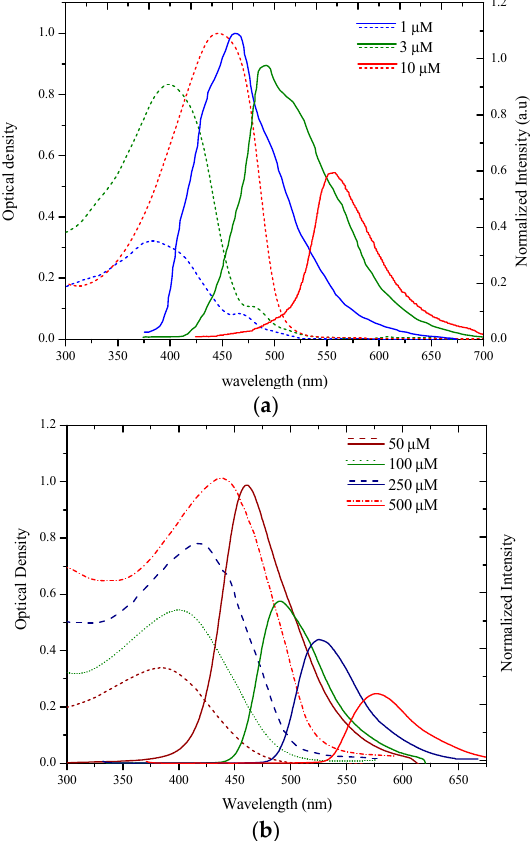
Figure 3. ( a ) The absorption spectra (dotted lines) and fluorescence spectra (in solid line) of the MEH–PPV in THF for three concentrations (1 to 10 µ M). The γ -radiation dose was maintained at 2 kGy for each solution; ( b ) The absorption spectra and fluorescence spectra of the BMP in THF for three concentrations (50 to 500 μ M). The γ -radiation dose was maintained at 2 kGy for each solution. (In the above figures, discontinuous line represents absorption and continuous line represents fluorescence).